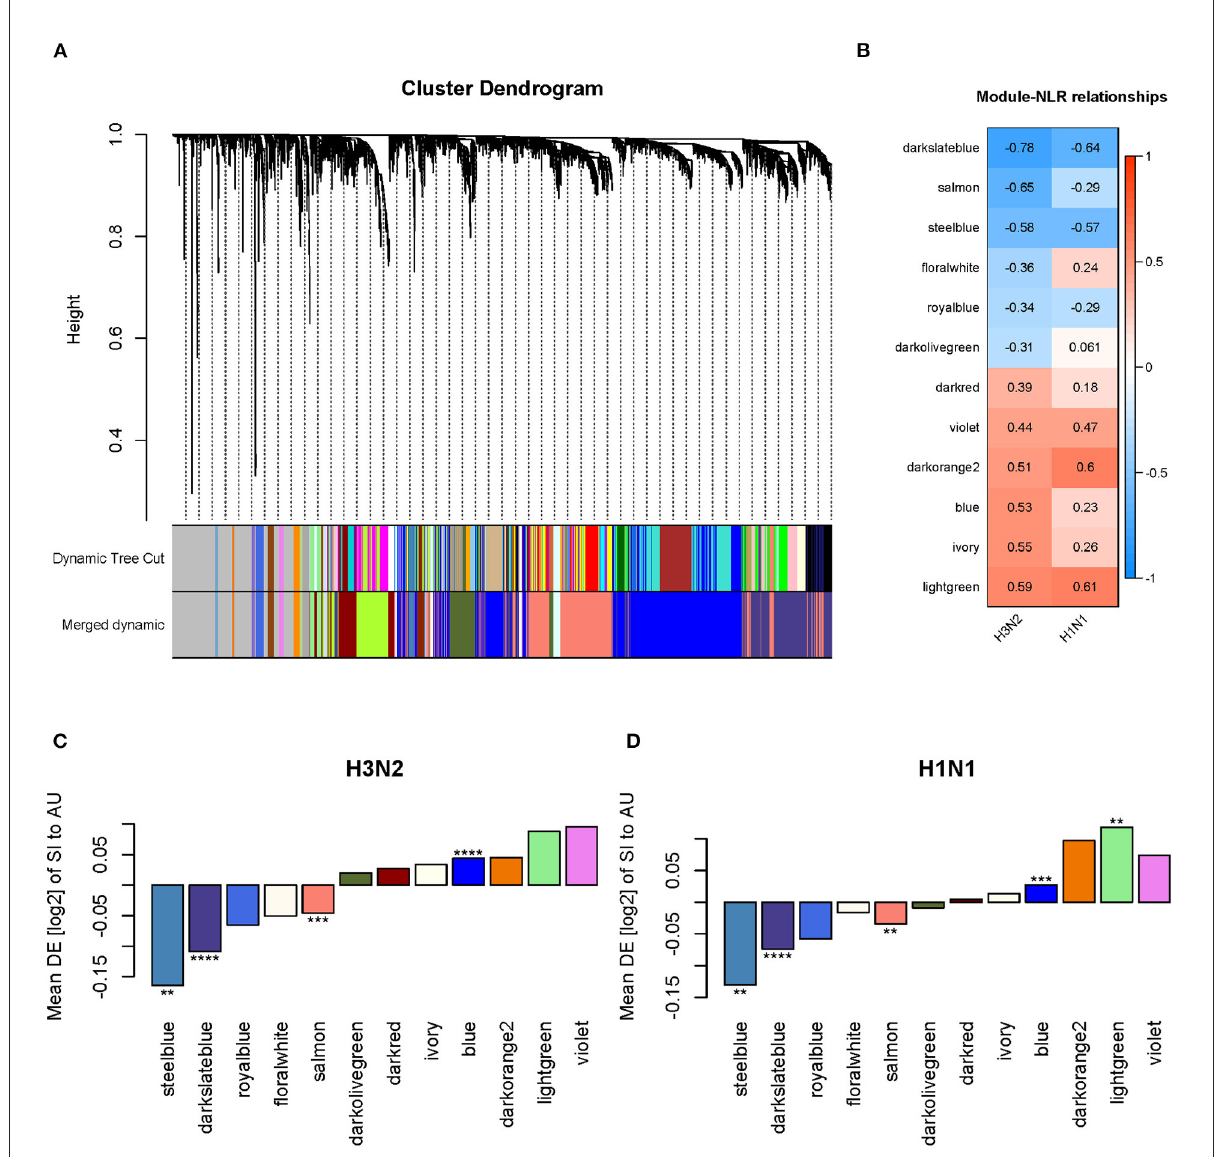
FIGURE11 Network analysis identified four disease modules associated with the NLR. (A) Gene dendrogram and co-expressed modules obtained by WGCNA. (B) Statistically significant modules correlated with the NLR. (C,D) Differential expression (DE) of SI group compared to AU group in each module in the discovery and validation cohorts (* p < 0.05, ** p < 0.01, *** p < 0.001, **** p < 0.0001).